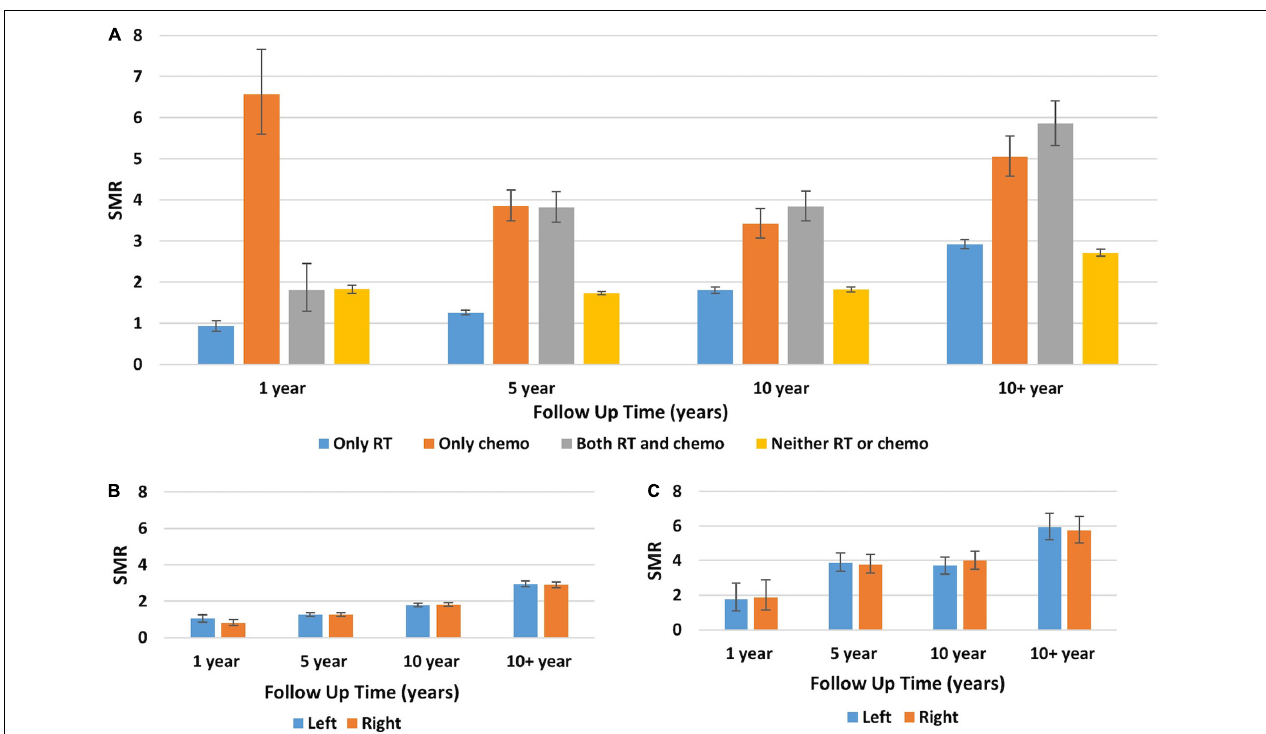
FIGURE 1 | Standard mortality ratios for death from heart disease in breast cancer patients stratified by treatment received, disease laterality, and era diagnosed. (A) The Y -axis represents the SMR for death from heart disease and the X -axis depicts the time since diagnosis in years. Each color represents a different treatment received by patients: blue, only radiotherapy; orange, only chemotherapy; gray, both radiotherapy and chemotherapy; yellow, neither chemotherapy nor radiotherapy. Throughout the follow-up, the two patient groups with the highest SMR for death from heart disease were patients receiving only chemotherapy and patients receiving both radiotherapy and chemotherapy. (B,C) The Y -axis represents SMR for death from heart disease and the X -axis depicts the time since diagnosis in years. Each color represents patients with either left-sided primary disease (blue) or right-sided primary disease (orange). Panel (B) shows patients who received only radiotherapy and panel (C) is patients who received both radiotherapy and chemotherapy. For all timepoints and treatment groups, the SMR for death from heart disease was similar regardless of disease laterality. Generated from SEER Database: Incidence – SEER 13 Regs excluding AK Custom Data (with additional treatment fields), Nov 2016 Sub (1992–2014) for SMRs – Linked To County. MP-SIR